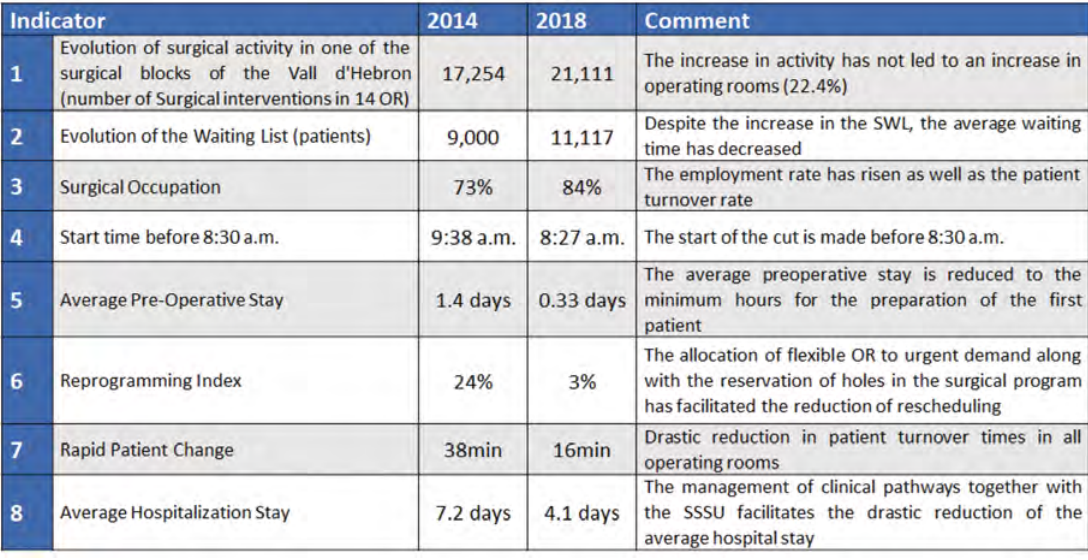
Table 2. Results by